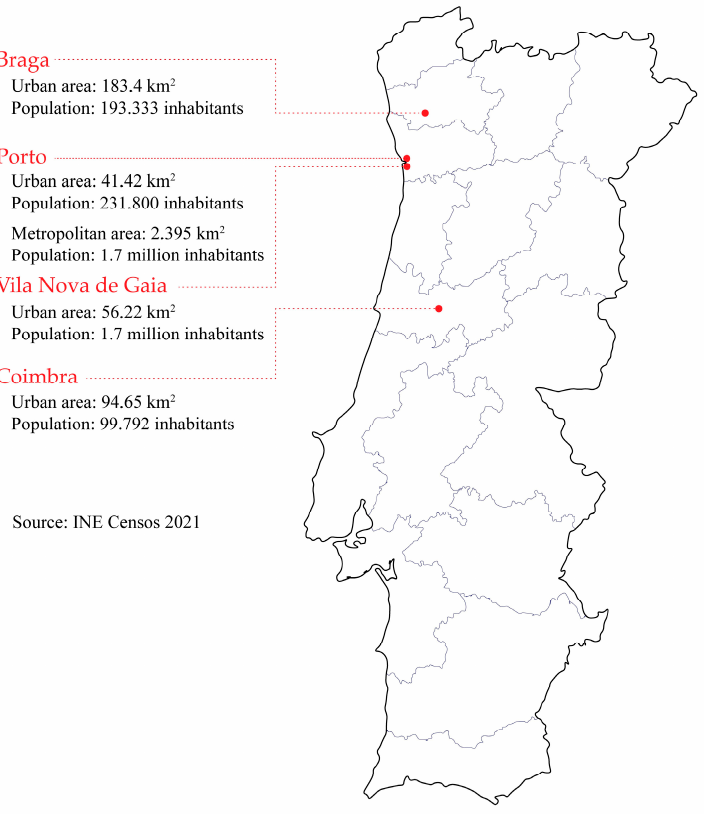
Figure 2. Location of the case studies.